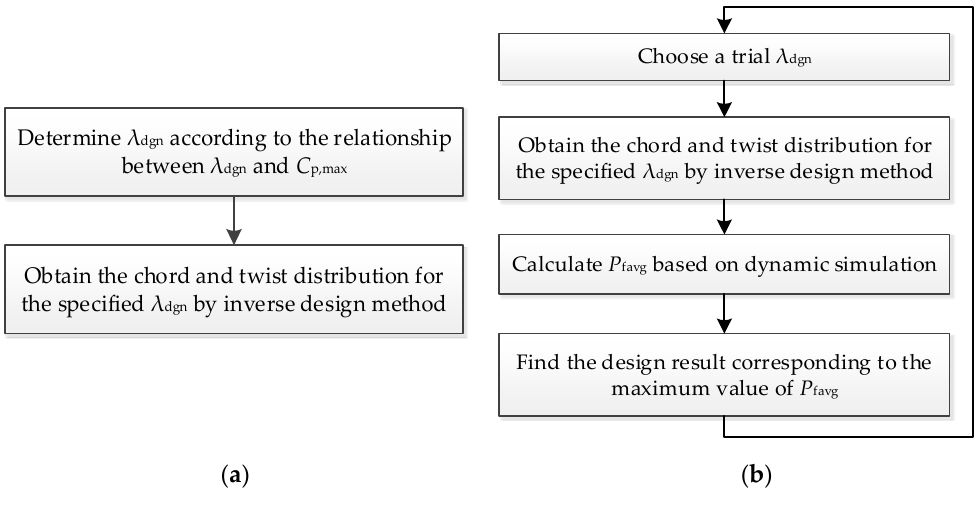
Figure 6. The schematic diagrams of the conventional inverse design and the proposed aerodynamic design. ( a ) Separated optimization in the inverse design method; ( b ) Joint optimization in the proposed method.